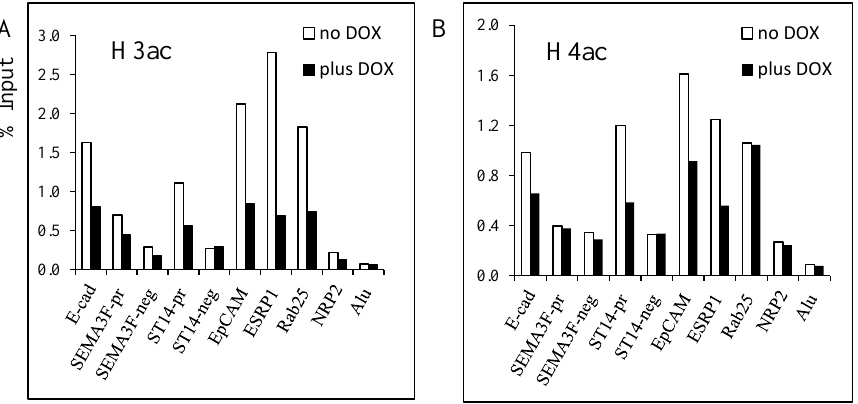
Figure 4. Decrease of histone H3 and H4 acetylation induced by ZEB1 binding on target genes. ChIP assays were performed with the rabbit anti-acetyl H3 ( A ), and anti-acetyl H4 ( B ) antibodies on H358 FlipIn ZEB1 cells grown for 48 h in the absence (white bars) or in the presence (black bars) of DOX. Results are expressed as % of input. Two independent experiments were performed with qPCR reaction in duplicate and one representative experiment is shown.